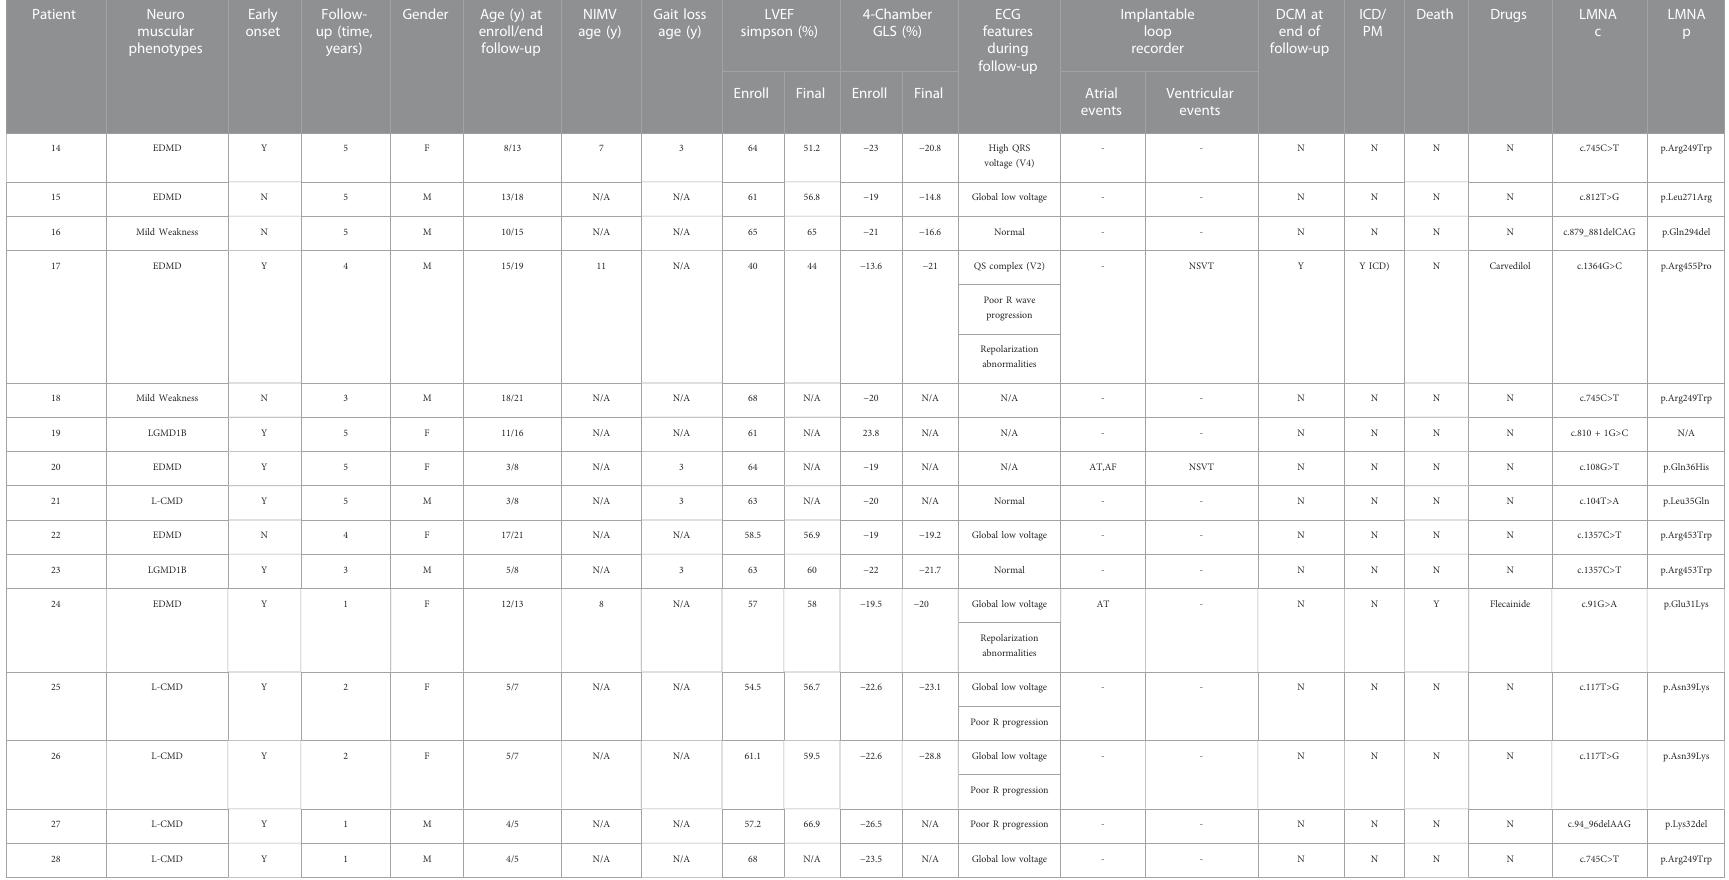
List of LMNA -related muscular dystrophy patients, major and minor cardiac events, and rare LMNA mutations. Abbreviations: L-CMD, LMNA -related congenital muscular dystrophy; EDMD, Emery – Dreifuss muscular dystrophy; LGMD1B, Limb – girdle muscular dystrophy 1B; M, male; F, female; DCM, dilated cardiomyopathy; ICD, implantable cardioverter de fi brillator; PM, pacemaker; AT, atrial tachycardia; AF, atrial fi brillation; NSVT, non-sustained ventricular tachycardia; SVT, sustained ventricular tachycardia; VF, ventricular fi brillation; GLS, global longitudinal strain; N/A, not available; AVB, atrioventricular block; IRBBB, incomplete right bundle branch